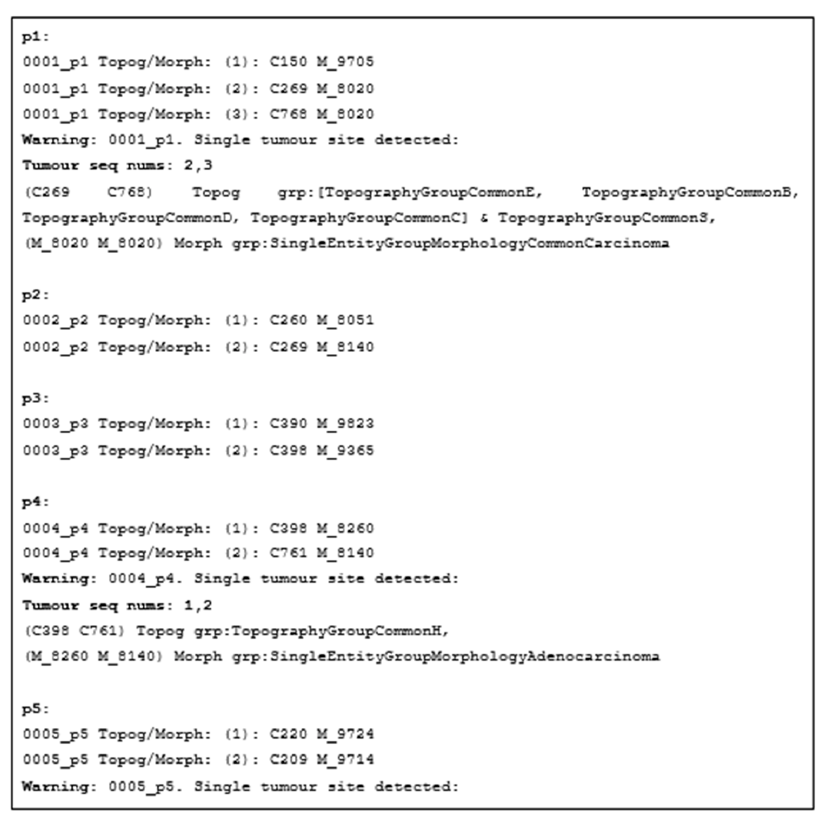
Figure A7. Output of the OWL-API programme interface for the same multiple-tumour test cases of Section 3. The highlighted “Warning” text indicates violation of the MPT rules for the tumour permutations and reasons provided underneath it.